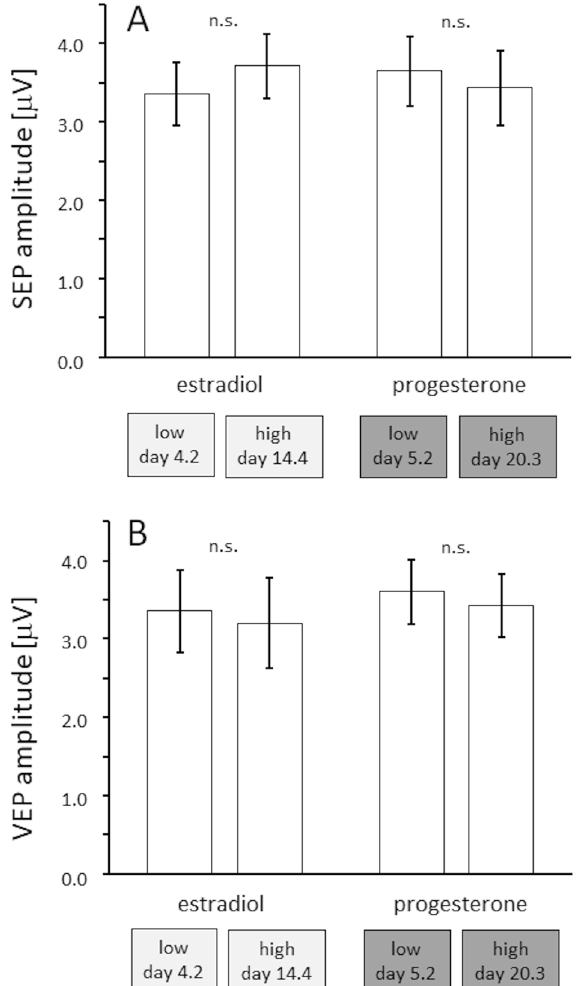
Figure 9. Effects of gonadal hormones on evoked potentials. Effect of lowest and highest levels of estradiol and progesterone on single-stimulation SEP ( A ) and VEP ( B ). Data are represented as mean ±